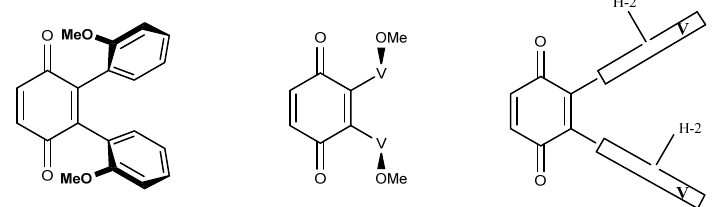
Figure A2. Three simplified representations of di-adduct 6b .